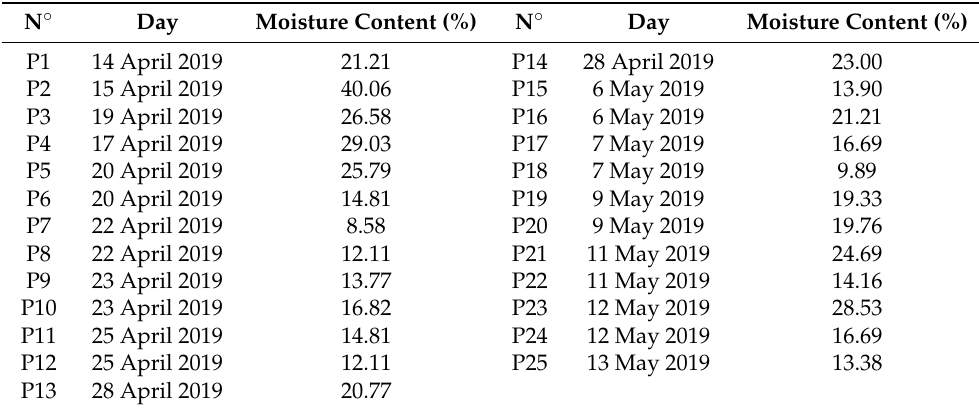
Table 3. Initial soil moisture contents in